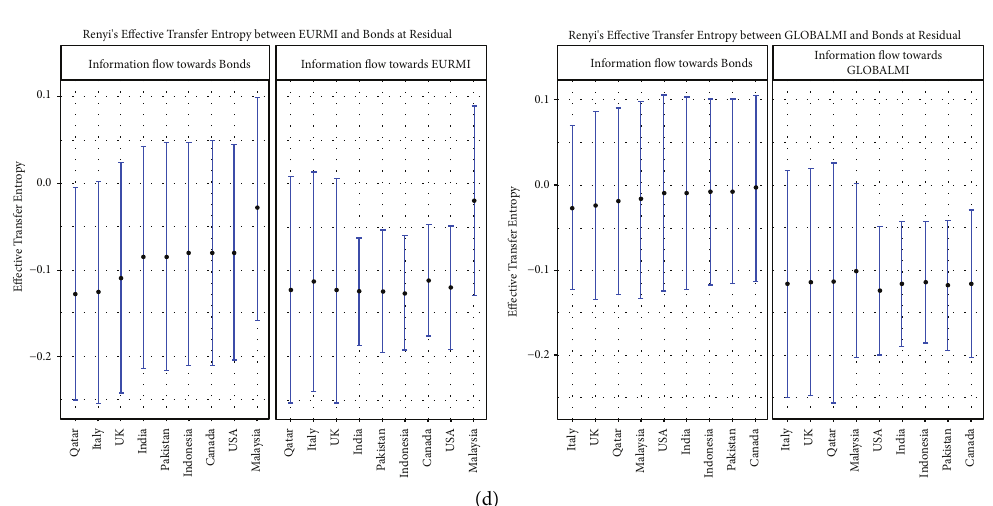
Figure 4: Transferentropiesbetween bonds andglobal equitiesat the frequency-domain level(IMFs1,3, 5,andresidual).(a) Renyi’seffective transfer entropy between BRIC and bonds at IMF1, (b) Renyi’s effective transfer entropy between DEVMI and bonds at IMF1, (c) Renyi’s effective transfer entropy between EMGMI and bonds IMF1, (d) Renyi’s effective transfer entropy between EURMI and bonds at IMF1, (e) Renyi’s effective transfer entropybetweenGLOBALMIandbondsatIMF1,(f)Renyi’seffectivetransferentropybetweenBRIC andbondsatIMF3, (g)Renyi’seffectivetransfer entropy between DEVMI and bonds at IMF3, (h) Renyi’s effective transfer entropy between EMGMI and bonds at IMF3, (i) Renyi’s effective transfer entropy between EURMI and bonds at IMF3, (j) Renyi’s effective transfer entropy between GLOBALMI and bonds at IMF3, (k) Renyi’s effective transfer entropy between BRIC and bonds at IMF5, (l) Renyi’s effective transfer entropy between DEVMI and bonds at IMF5, (m) Renyi’s effective transfer entropy between EMGMI and bonds at IMF5, (n) Renyi’s effective transfer entropy between EURMI and bonds at IMF5, (o) Renyi’s effective transfer entropy between GLOBALMI and bonds at IMF5, (p) Renyi’s effective transfer entropy between BRIC and bonds at residual, (q) Renyi’s effectivetransferentropybetweenDEVMIandbondsatresidual,(r)Renyi’seffectivetransferentropybetweenEMGMIandbondsresidual,(s)Renyi’s effective transferentropybetween EURMI and bondsat residual, and(t) Renyi’seffectivetransfer entropybetween GLOBALMIand bondsat